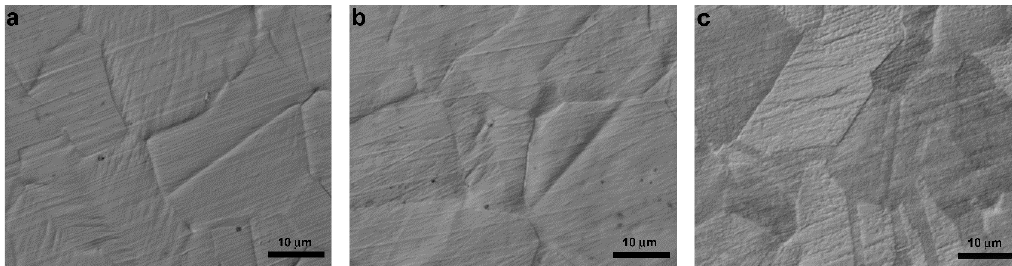
Figure 2. Surface morphology of Type-A ( a ), Type-B ( b ) and Type-C ( c ) treated samples. Table 1. Roughness parameters R a , R z and R c , for samples untreated and treated as indicated. Sample Type